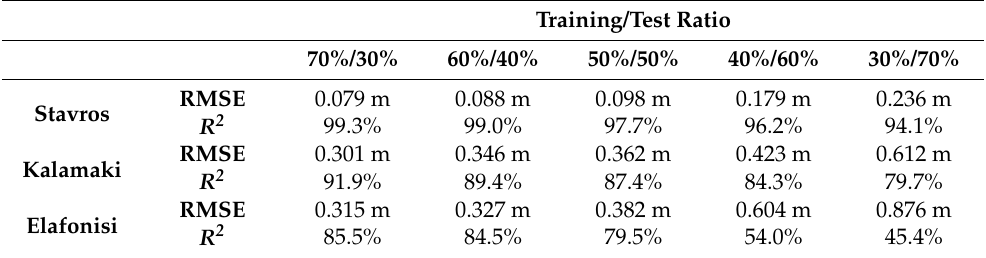
Table 3. Accuracy metrics at each study area and for each training/test model configuration.